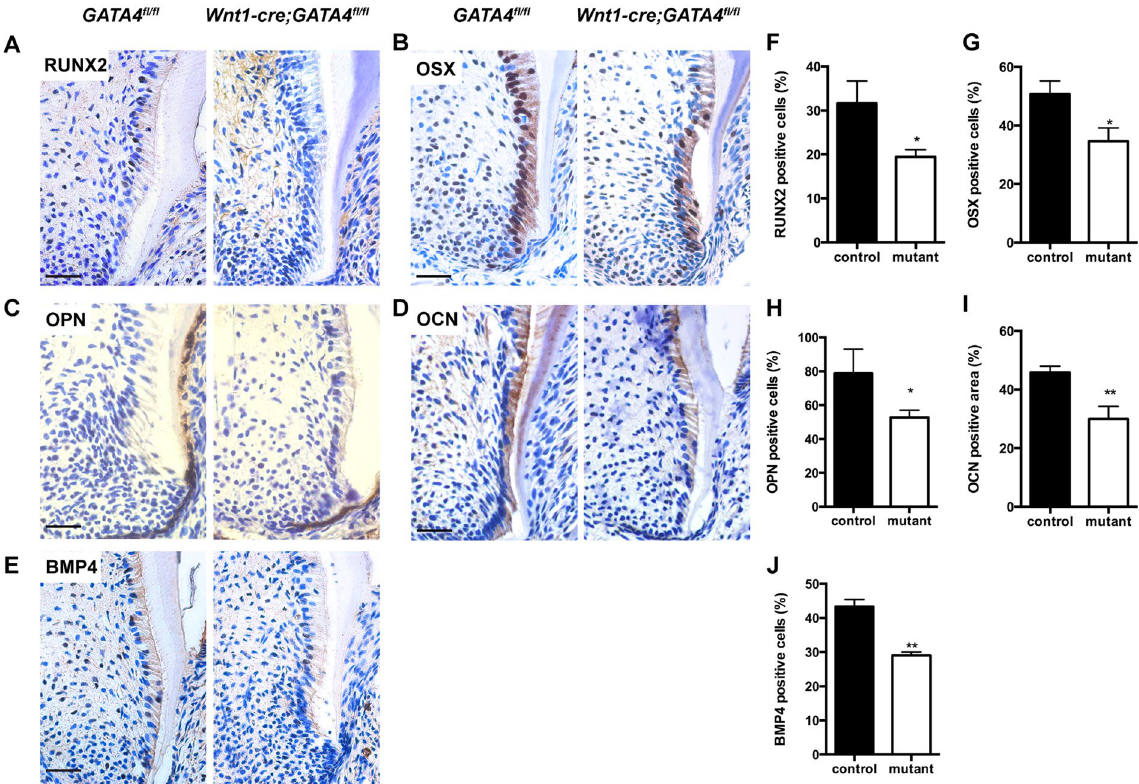
Figure 2. Osteo/odontogenic related changes in gene expression in dental cells. ( A–E ) Immunohistochemistry staining images showing expression levels of RUNX2 ( A ), OSX ( B ), OPN ( C ), OCN ( D ), and BMP4 ( E ) in root of Wnt1-Cre;GATA4 fl/fl mice at P14. ( F–J ) Percentages of RUNX2 ( F ), OSX ( G ), OPN-positive cells ( H ), OCN- positive area ( I ) and BMP4-positive cells ( J ) in the control and mutant groups were calculated (Bar: 50 μ m). * P < 0.05, ** P <